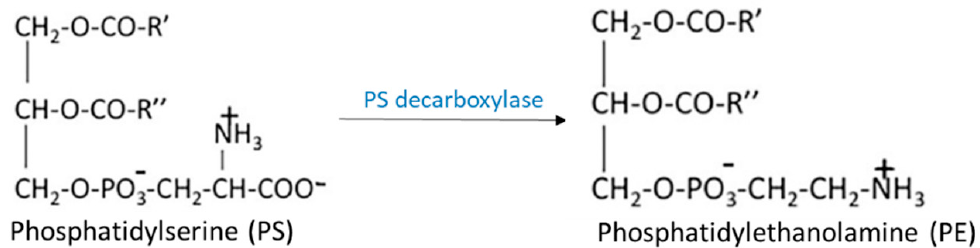
Figure 4. Synthetic route of PE by decarboxylation of PS. PS with the action of PS decarboxylase leads to PE synthesis in mitochondria.